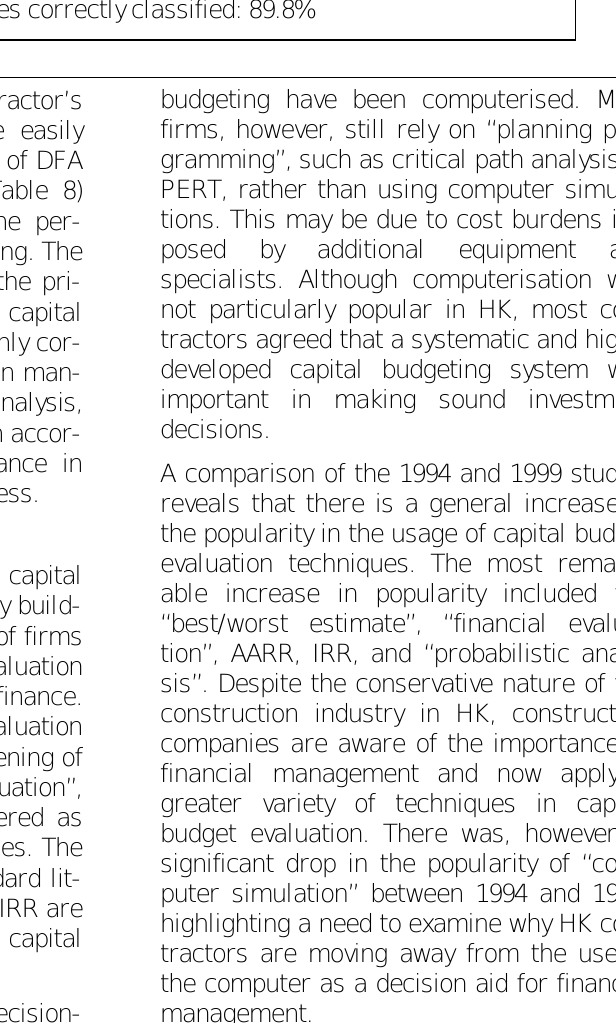
Predicted group membership Actual group Number of cases 1 2 3 0 2 90.0% 0.0% 10.0% 5 1 0.0% 83.3% 16.7% 1 21 4.3% 4.3% 91.3%